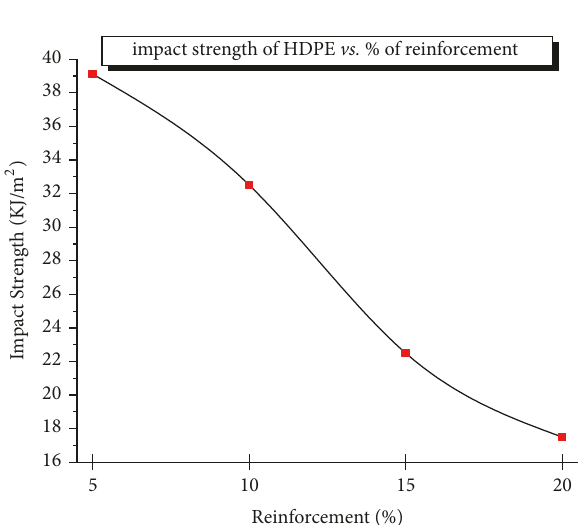
Figure 9: Impact strength varying with %